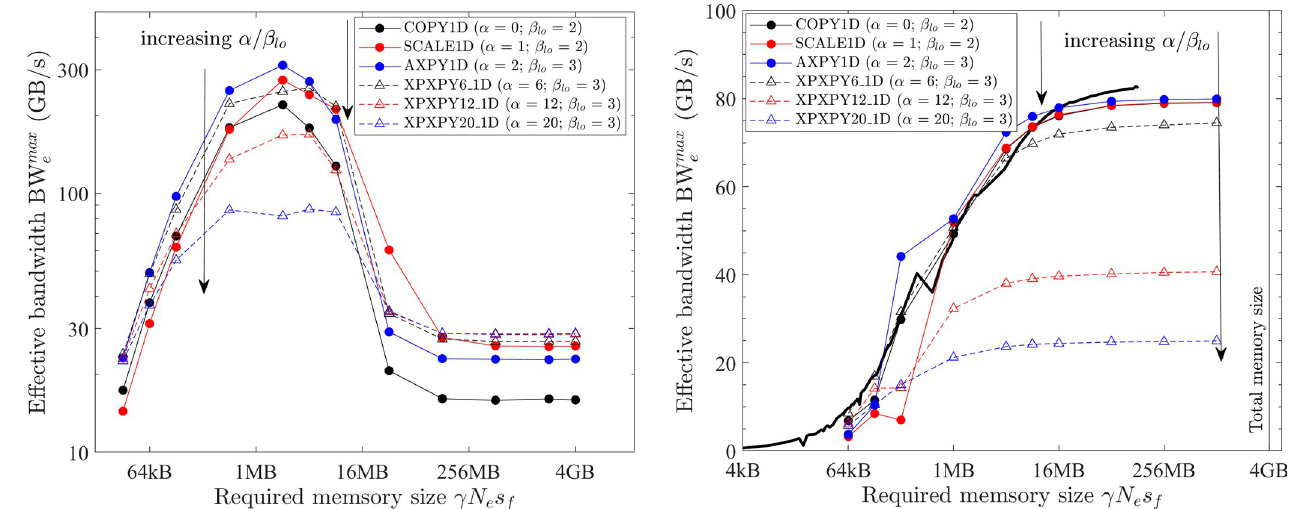
Fig 10. Maximal effective bandwidth of various vector operations. (a) PC CPU platform (f32). (b) PC GPU platform (f64).